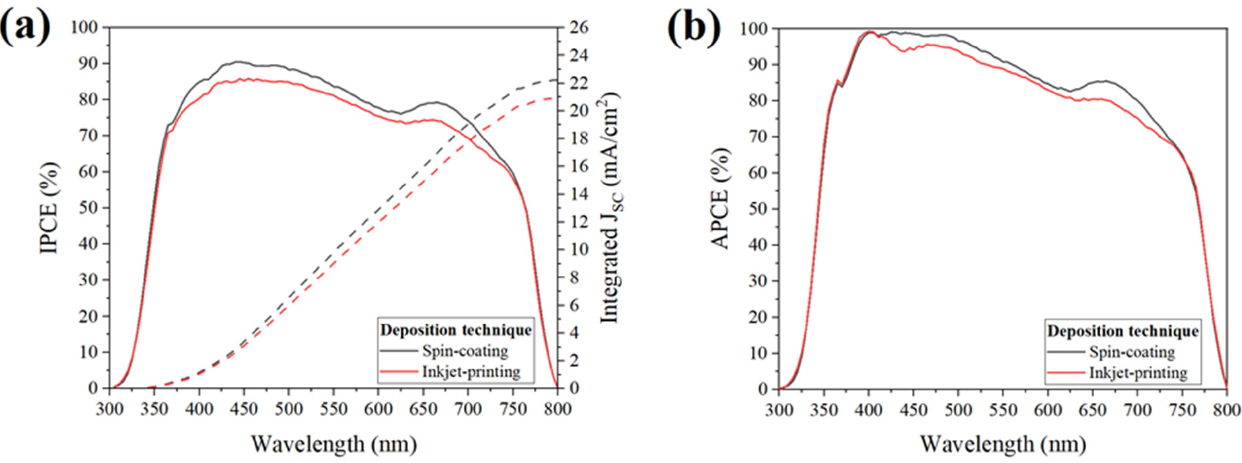
Figure 7. ( a ) IPCE and ( b ) APCE spectra of the solar cells fabricated by the different deposition techniques of the perovskite absorbent layer.